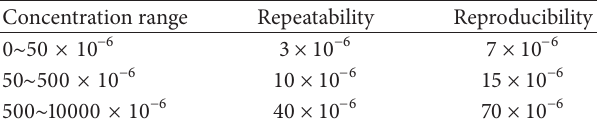
Table 2: Precision requirement of index gases in China. Concentration range